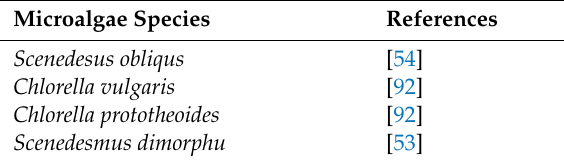
Table 5. Microalgae species used in brewery wastewater treatment by various authors.